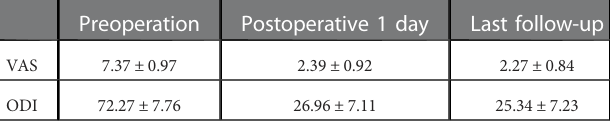
TABLE 2 The VAS and ODI score preoperatively and at each time point postoperatively ( n =41).